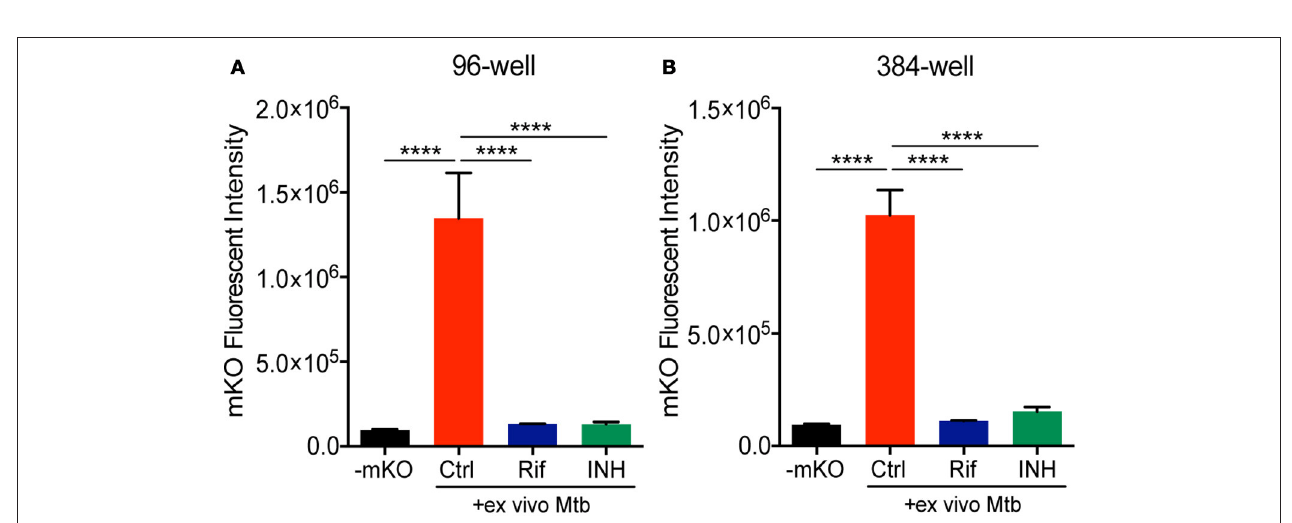
FIGURE 3 | Deconstructed granuloma assay in 96- and 384-well platforms. Lung cells isolated from infected mice were cultured in (A) 96-well or (B) 384-well plates. Tet-ON inducible mKO/mCherry Mtb were added to the cultures at MOI 0.1 with or without addition of Rif and INH. The fluorescence signal of mKO was acquired with a plate reader. Data are shown as mean ± standard deviation. The experiments were repeated at least two times. P -value was calculated using one-way ANOVA test with Tukey’s multiple comparisons. **** P <